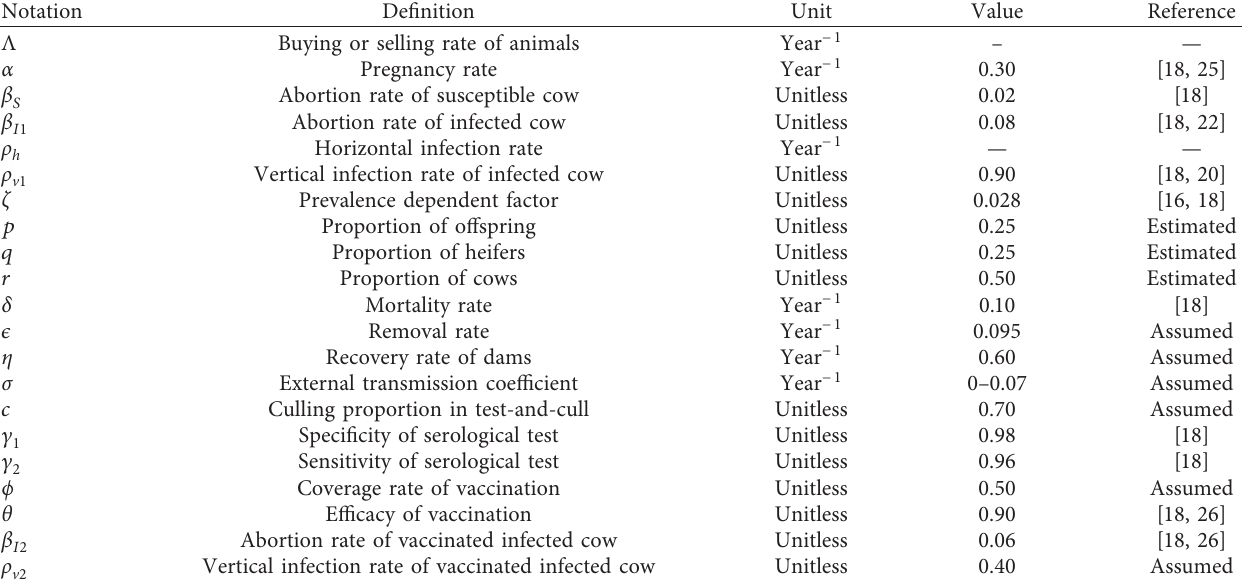
Table 1: Description of parameters and variables used in the